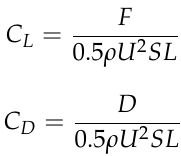
Figure 3. Images of porous